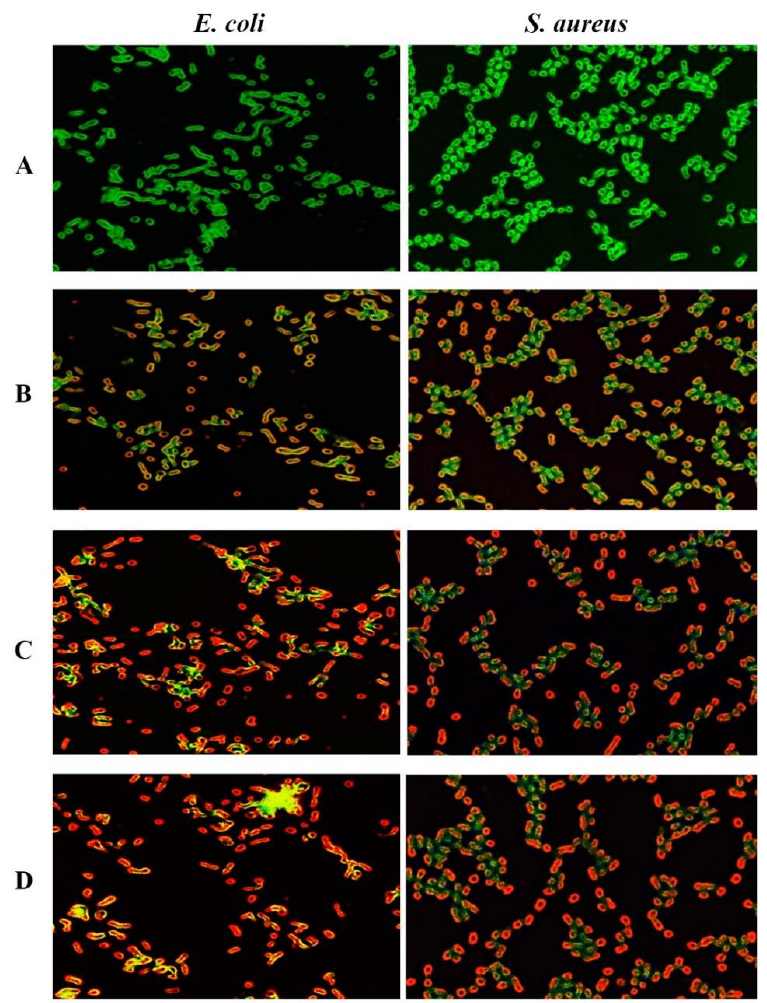
Figure 10. Fluorescence microscopic images of the green and red fluorescence stained S.aureus and E.coli . ( A ): non-treated bacterial strains. Bacterial cells treated with; ( B ) GONPs, ( C ): GONPs–PEG and ( D ): GONPs–PEG– N.sativa.